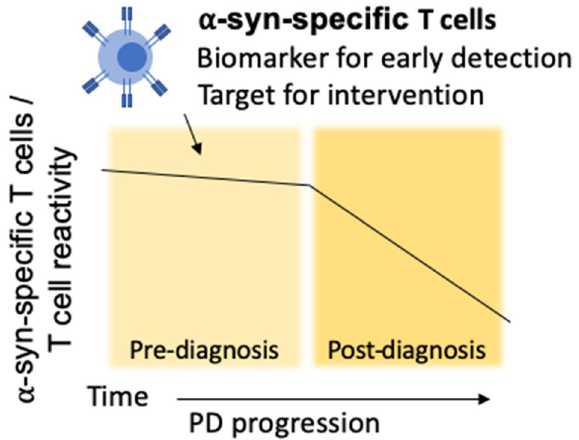
Figure 5. The potential role of α-syn-specific T cells in PD pathogenesis. α-syn-specific T cell reactivity decrease as PD progresses 10 , with the highest reactivity present pre-diagnosis of motor PD. α-syn-specific